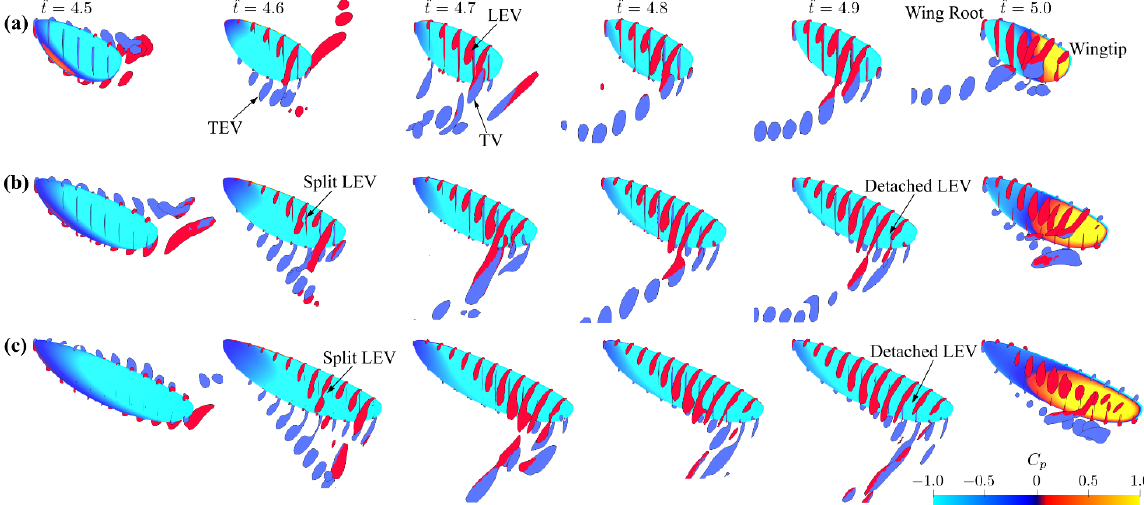
Figure 5. Flow evolution at different time instances for ( a ) AR = 3, ( b ) AR = 4.5, and ( c ) AR = 6. Red and blue colors indicate positive spanwise (from root to tip) and negative spanwise (from tip to root) rotating vortices, respectively. C p is the pressure coefficient: C p = p